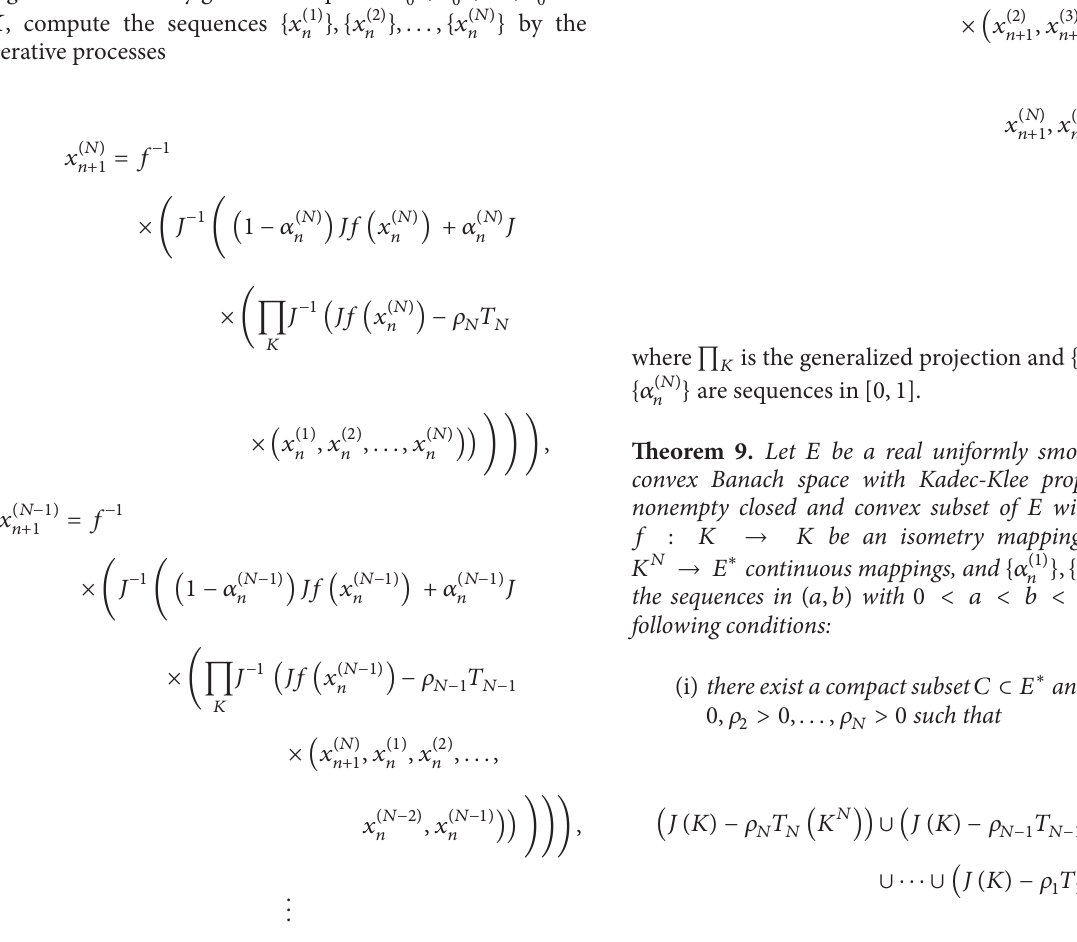
Algorithm 8. For any given initial points 𝑥 𝐾 , compute the sequences {𝑥 (1) iterative